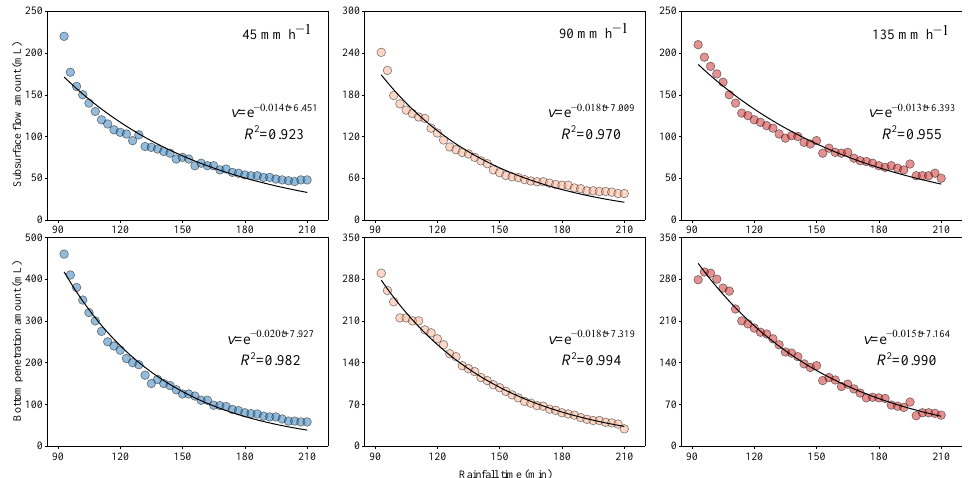
Figure 11. Relationships between the times and subsurface flow and bottom penetration after the rainfall simulations ends.